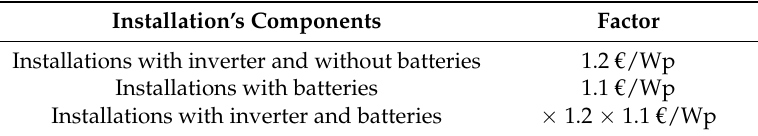
Table 3. Weighting factors on the initial investment due to component replacement.